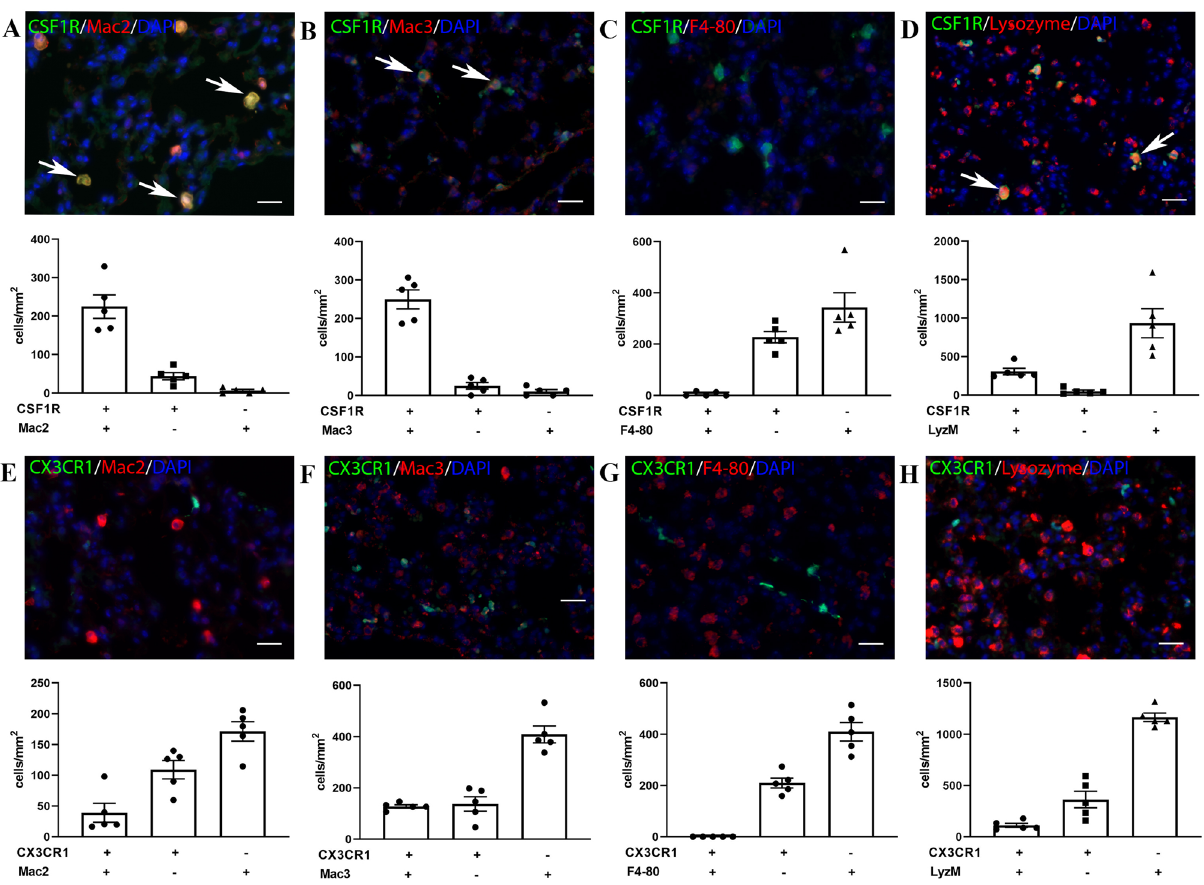
Figure 4. Identification of macrophages in the lung using reporter lines and macrophage antibodies. A-D: Dual fluorescence for GFP and macrophage antibodies in lung sections from CSF1R-EGFP mice. Most CSF1R+ cells are labeled with Mac2 ( A ), Mac3 ( B ), and anti-Lysozyme antibody, clone EPR2994(2) ( D ), but not with the antibody to F4-80 ( C ). E–H: Dual fluorescence for GFP and macrophage antibodies in lung sections from CX3CR1 GFP mice. CX3CR1 has limited co-localization with Mac2 ( E ) and Mac3 ( F ), and lysozyme M ( H ). Please note that a significant population of F4/80+ cells is noted in the pulmonary parenchyma; however, these cells do not express CSF1R ( C ) and CX3CR1 ( G ). Scale bar: 20